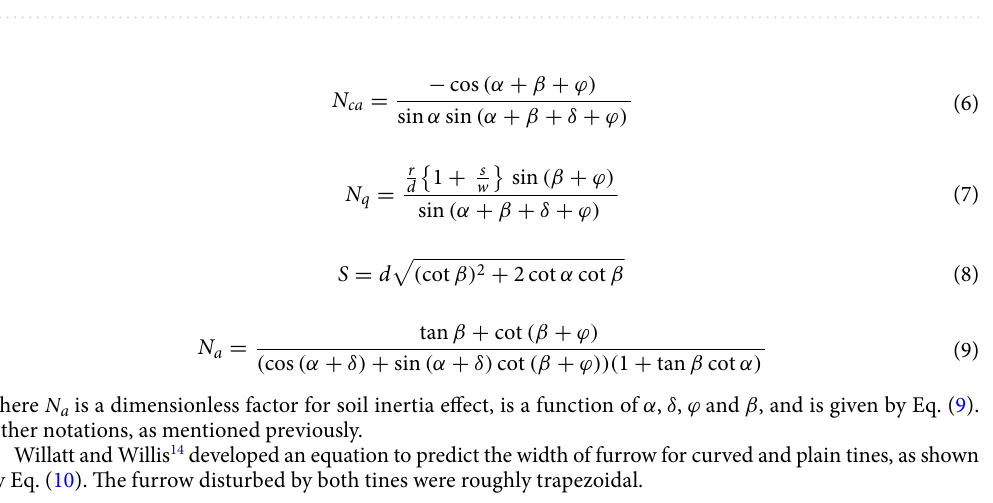
Figure 3. Sensors for force measurement at the three-point linkages behind the soil bin trolley ( a ) Top link ( b ) Right lower link ( c ) Left lower